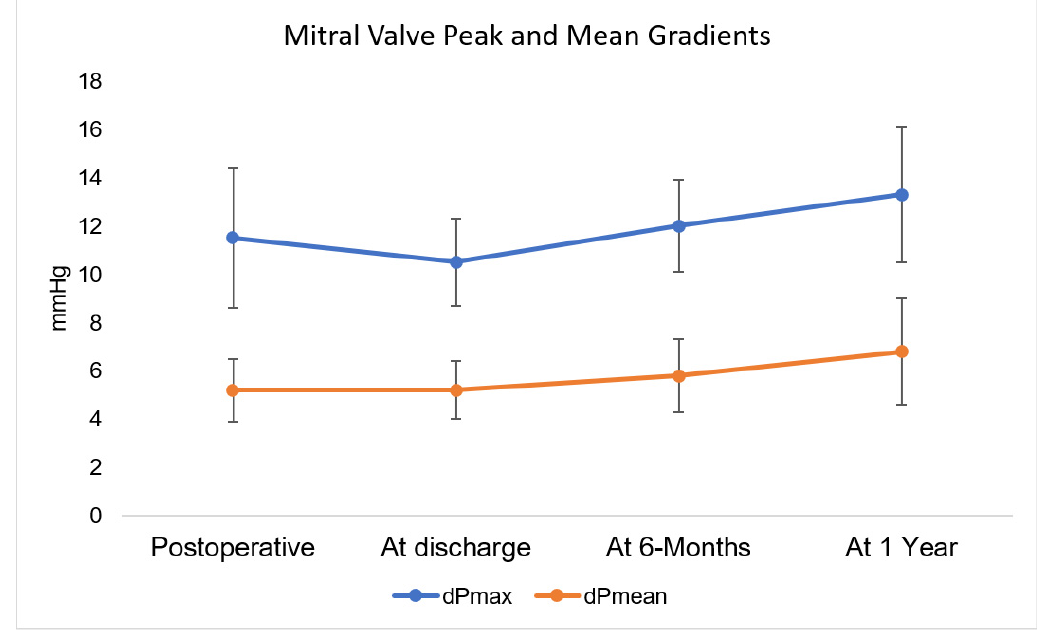
Figure 4. Mitral valve peak and mean gradients.